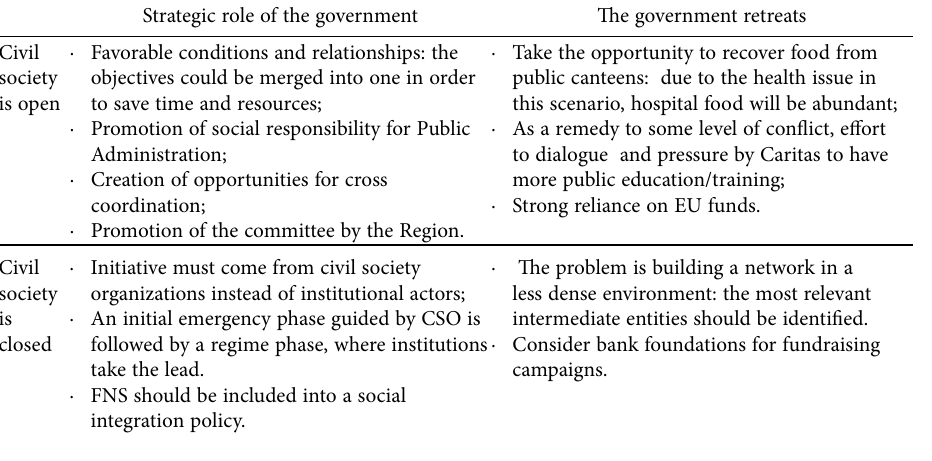
Table 1. Contingency plan for “governance and network”.